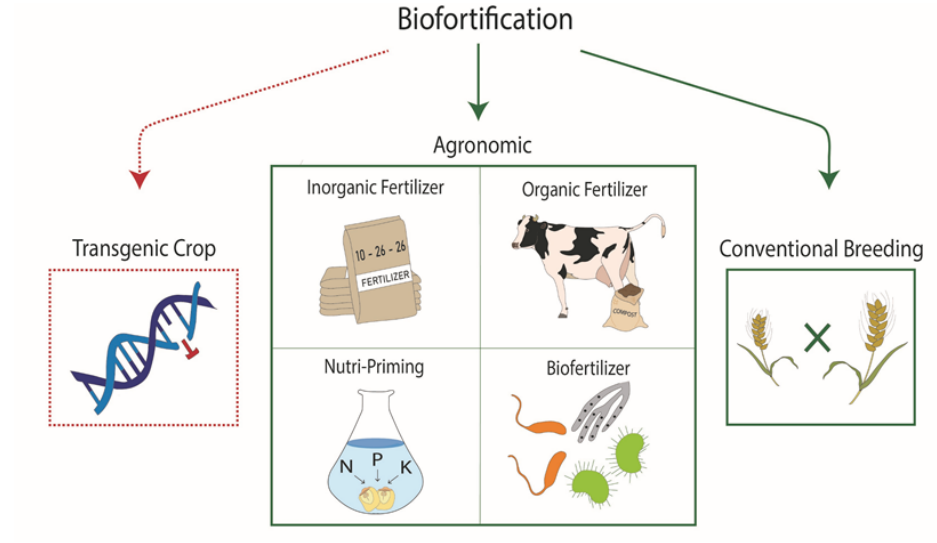
Figure 1. The three primary biofortification approaches for crops are transgenic, agronomic, and conventional breeding. Green solid arrows signify globally accepted approaches, while the red dashed arrows signify non-globally accepted approaches. Illustrated by Jorge Ruiz-Arocho.